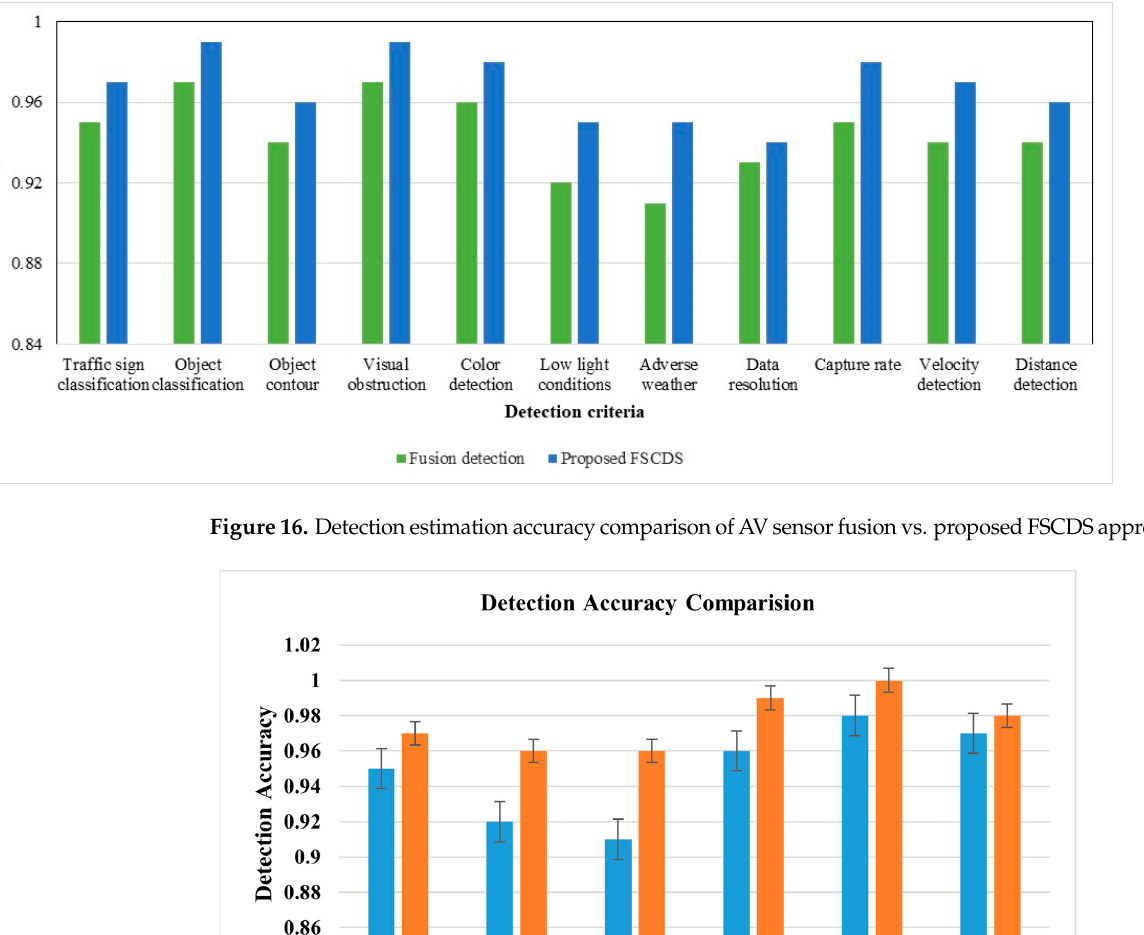
Figure 15. AV sensors fusion detection accuracy estimation with respect to car sensors.